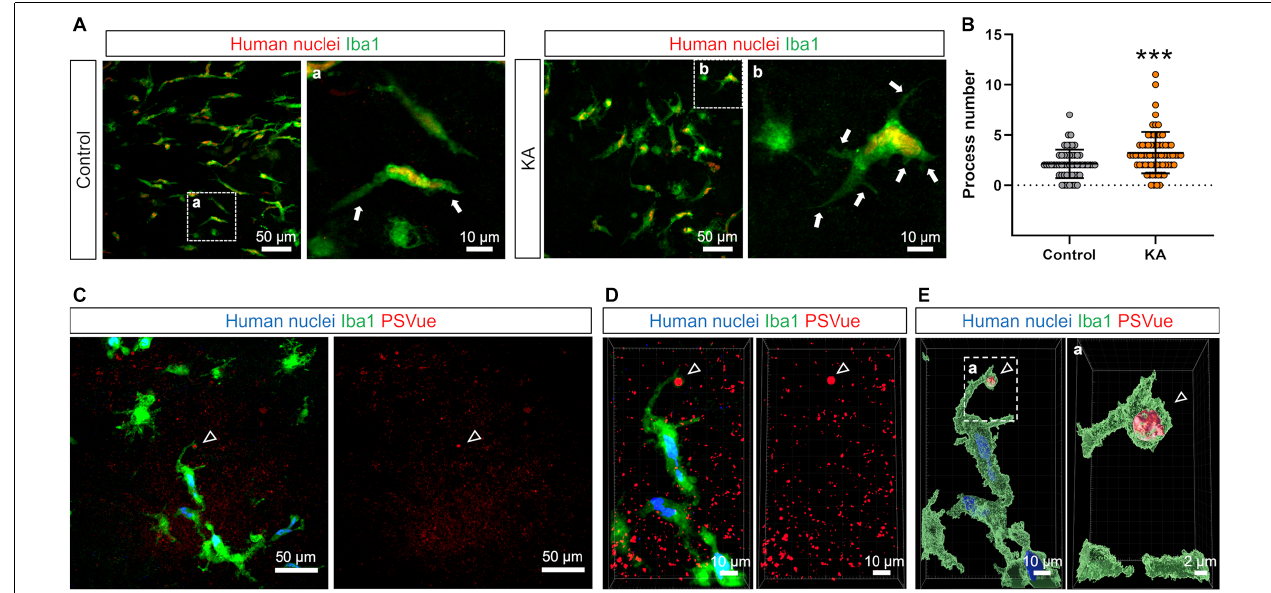
FIGURE 4 | Transplanted iCell-MG formed phagocytic cups. (A) Representative images of iCell-MG in the control (upper) and KA (lower) slice cultures immunostained for human nuclei (red) and Iba1 (green) at 21 DIV. Magnified images of the regions outlined by dashed squares are shown (right panels, in A and B ). iCell-MG had more processes in the KA-treated cultures than the control cultures (arrows). (B) The number of processes of iCell-MG (per cell) in the control and KA-treated cultures. The process number was increased by KA treatment. *** p < 0.001, Mann-Whitney rank sum test, n = 53 and 69 cells from two slices, each from one mouse. Data represent the mean ± SD. (C) Representative images of iCell-MG in the KA-treated cultures immunostained for human nuclei (blue) and Iba1 (green) following PSVue staining (red). PS was encapsulated in an Iba1-positive phagocytic cup (arrowheads). (D,E) A three-dimensional (3D) reconstruction of the images shown in (D) . PS was encapsulated in an Iba1-positive phagocytic cup ( D,E , arrowheads). Magnified images of the regions outlined by dashed squares are shown (right panel, in A–E